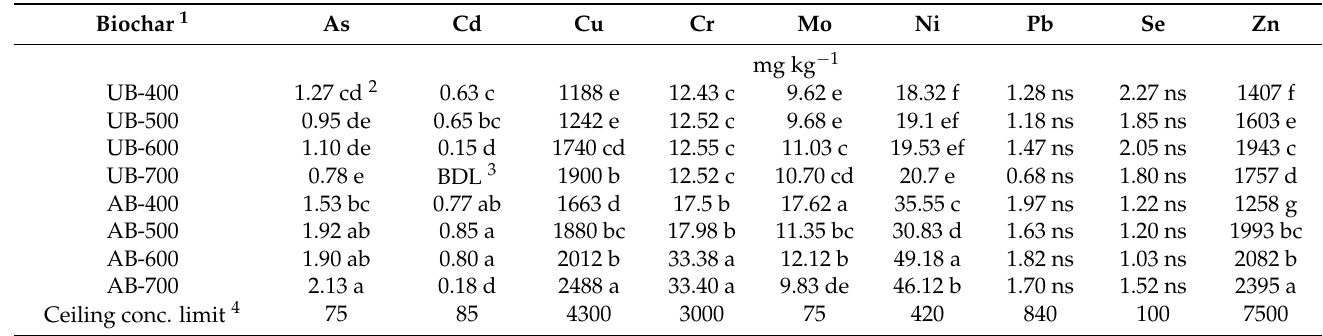
Table 4. Concentration of heavy metals (dry-weight basis) in biochars obtained from poultry litter at different temperatures (n